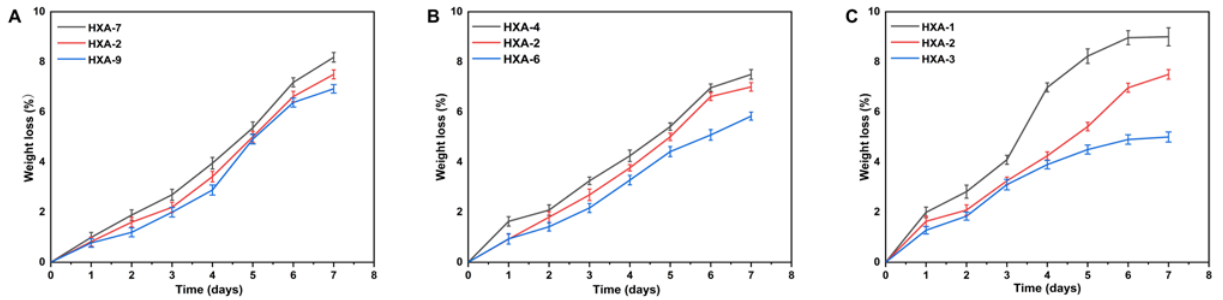
Figure 8. Effect of different formulation components on the biodegradation of hydrogels, such as ( A ) xanthan gum (HXA-2,7,9), ( B ) AMPS (HXA-2,4,6), and ( C ) EGDMA (HXA-1,2,3).